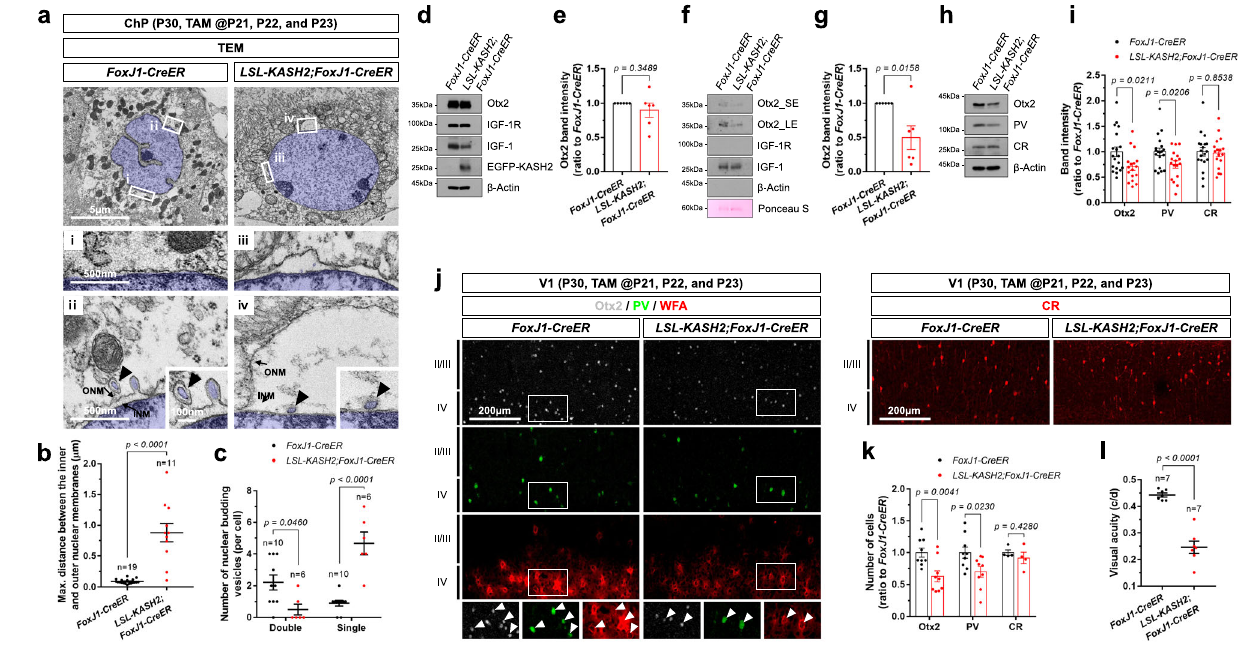
Fig. 8 | Otx2 secretion is suppressed LSL-KASH2;FoxJ1-CreER mice. a Sections (70nm)ofChPfromP30 FoxJ1-CreER and LSL-KASH2;FoxJ1-CreER mousebrainwere counterstained for ultrastructural imaging by electron microscope. The nuclei of the ChP cells are pseudo-colored in blue. In the mice, CreER recombinase was activatedbyinjectionoftamoxifenatP21,P22,andP23.(i~iv)Magni fi edversionsof the corresponding boxed areas on the top row. Arrowheads indicate the nuclear membranebuddingvesicles.AdotinthegraphsrepresentsMax.distancebetween the inner and outer nuclear membranes ( b ) and the number of OTX2-containing perinuclear and cytoplasmic vesicles ( c ) in a cell. Long sidebars indicate mean values, and error bars denote SEM obtained from 8 different samples (4 indepen- dent litters). The numbers of cells analyzed are shown in the graphs. The ChP ( d ), CSF ( f ), and V1 area of the cerebral cortex ( h ) were isolated from P30 FoxJ1-CreER and LSL-KASH2;FoxJ1-CreER mice ( n =4, each), and the levels of Otx2 in those samples were examined by WB. Relative amounts of proteins loaded in each lane were determined by comparing band intensities of ß-Actin ( d, h ) and 60kDa